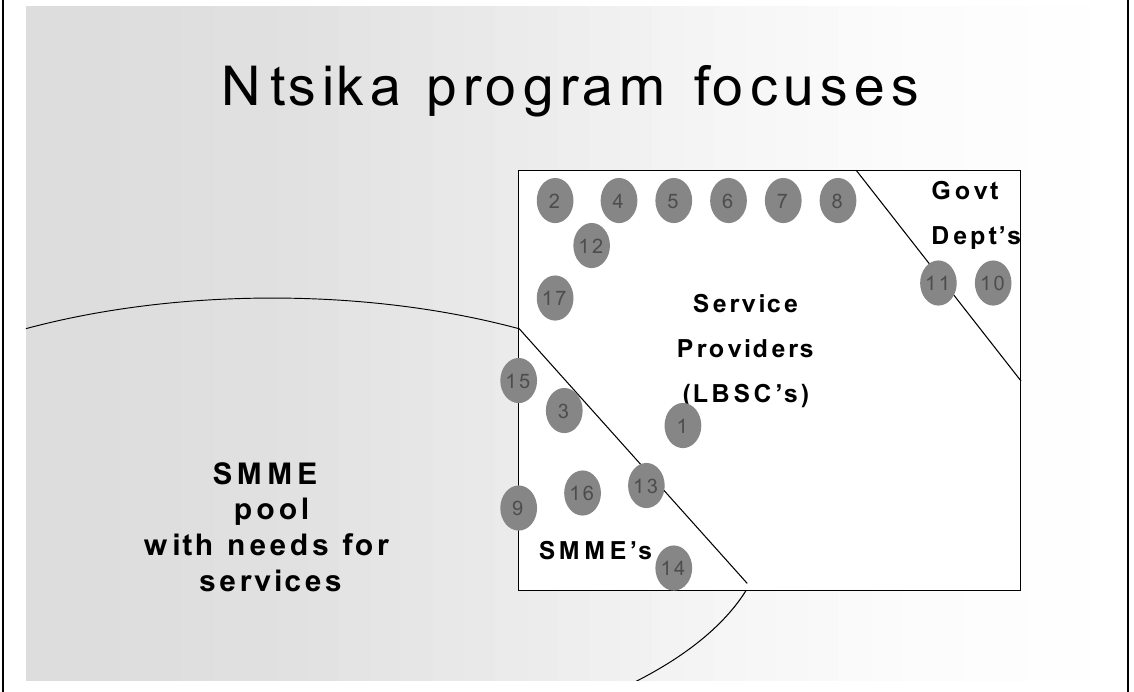
Graphical presentation showing that the program focuses of Ntsika programs lean towards service providers more than towards SMME(cid:146)s (own compilation)